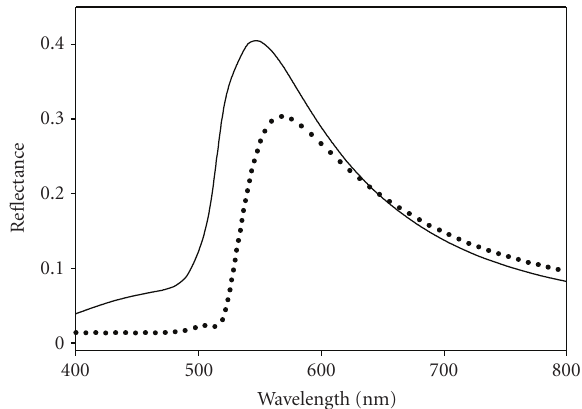
Figure 2: Reflectance of a two-dimensional array of 200 nm gold nanoparticles deposited on glass separated by an inter-particle distance of 400 nm. Solid line: dipolar approximation, dotted line: multipolar